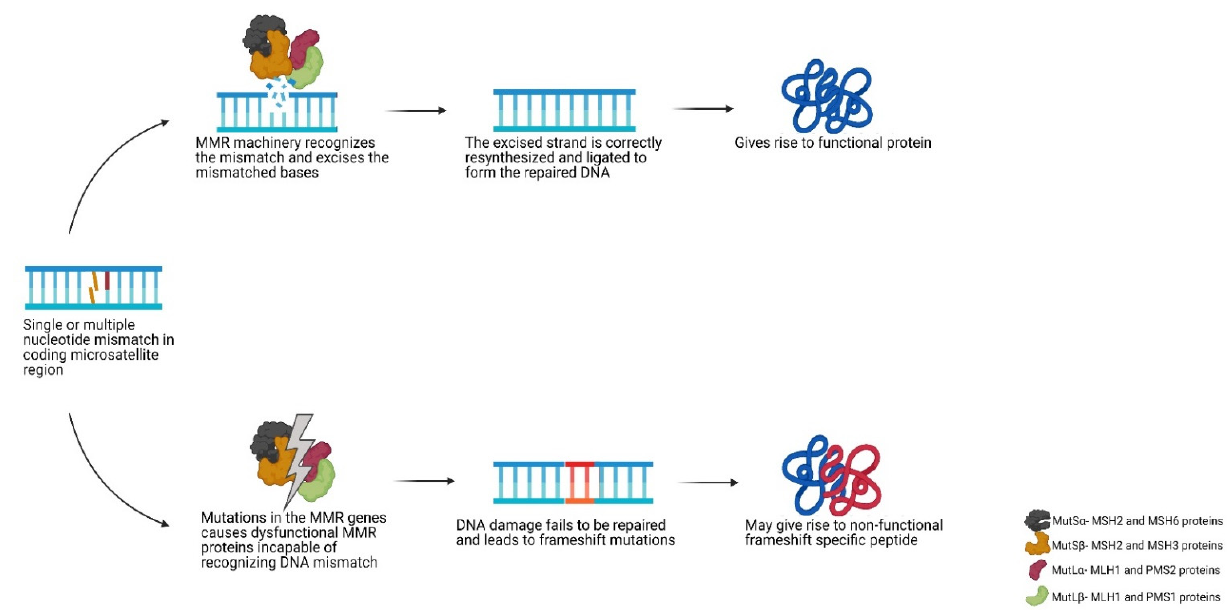
Figure 2. Schematic view of the DNA mismatch repair pathway. Abbreviations used- MMR: mismatch repair.